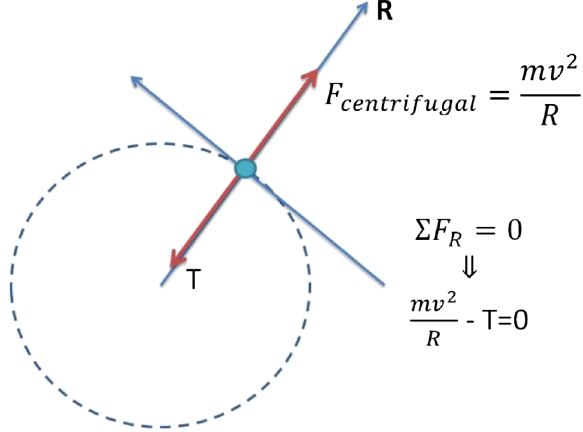
FIG. 1. Viewing centrifugal force as a real force acting on the spinning ball leads to the correct equation but is likely to produce